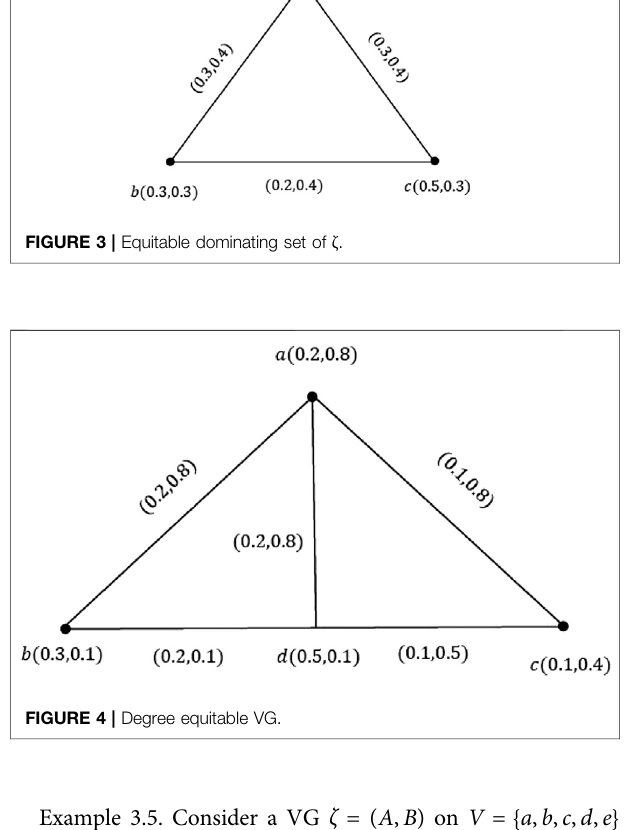
FIGURE 6 | Strong EDS of ζ